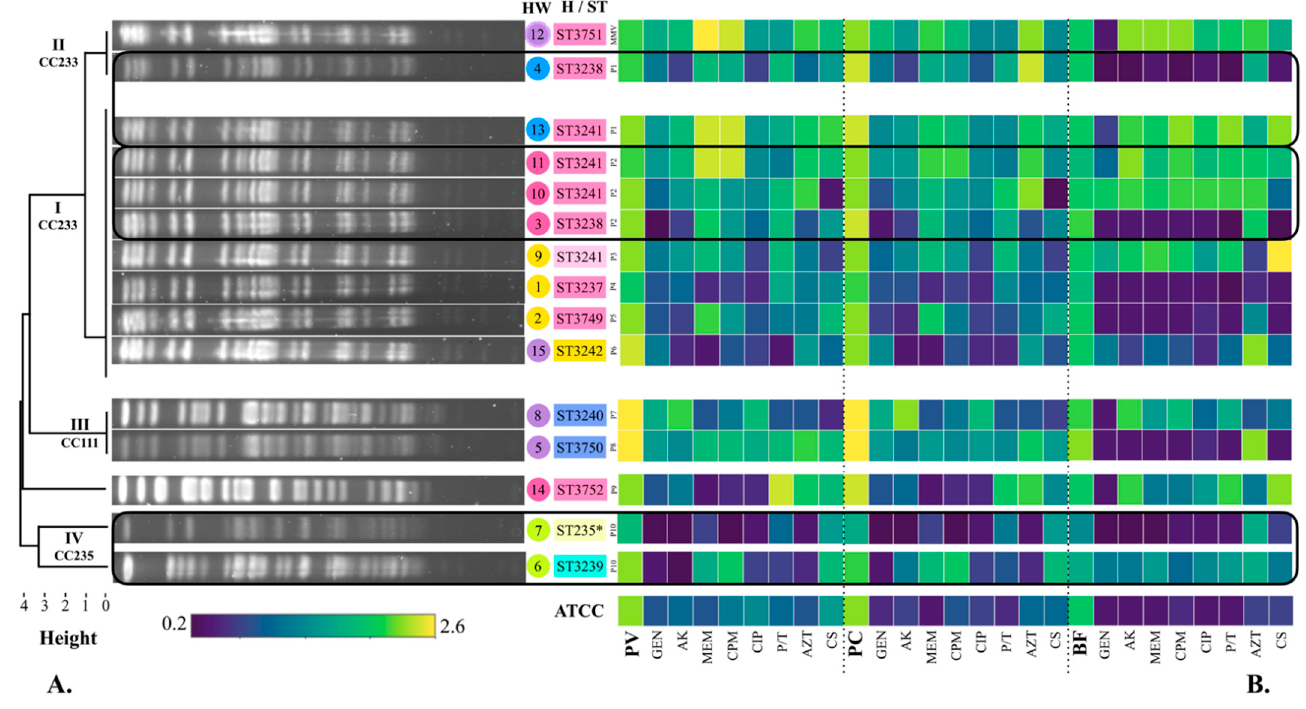
Figure 2. Phylogenetic tree of the 15 P. aeruginosa strains based on their electrophoretic pattern (PFGE), phenotypic production of virulence factors, and sequence type (ST). ( A ) Pulsed-field gel electrophoresis (PFGE). Electrophoretic patterns were obtained by PFGE with the Spe I enzyme. The phylogenetic tree was built with the unweighted pair group method with arithmetic mean (UPGMA) according to the PFGE electrophoretic patterns. Clades I, II, III, and IV were obtained. Strains from clades I and II were designated as closely related and considered part of the outbreak. CC: Clonal complex. The strain number followed by its identified ST is shown. Colour of the strain is given by the hospital ward (HW) according to Figure 1: Yellow: emergency (E), Blue: surgical therapy (STx), Pink: oncology (O), Purple: neonatal intensive care unit (NICU), Green: infectious diseases outpatient (I). Colour of the ST is given by the mexR-nalC-nalD haplotype (H): H12 (pink), H28 (blue), H29 (light blue), H30 (light green), H31 (light pink), H32 (yellow). High-risk clone ST235 is highlighted with a *. Number of patients is shown as well (P1–P10). MMV: Multidose MEM vial. ( B ) Phenotypic production of pyoverdine, pyocyanin, and biofilm. Virulence factors: PV: